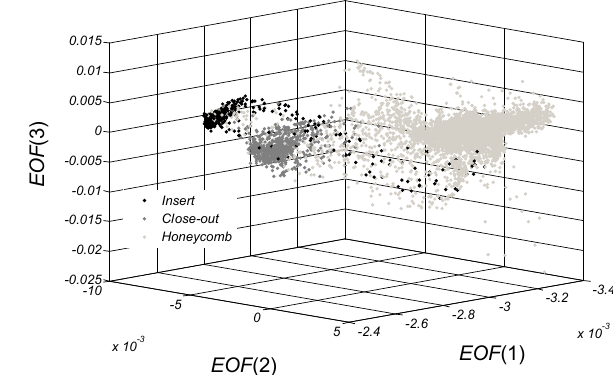
Figure 7. Visualization of first three EOFs of the GFRP-training sample.